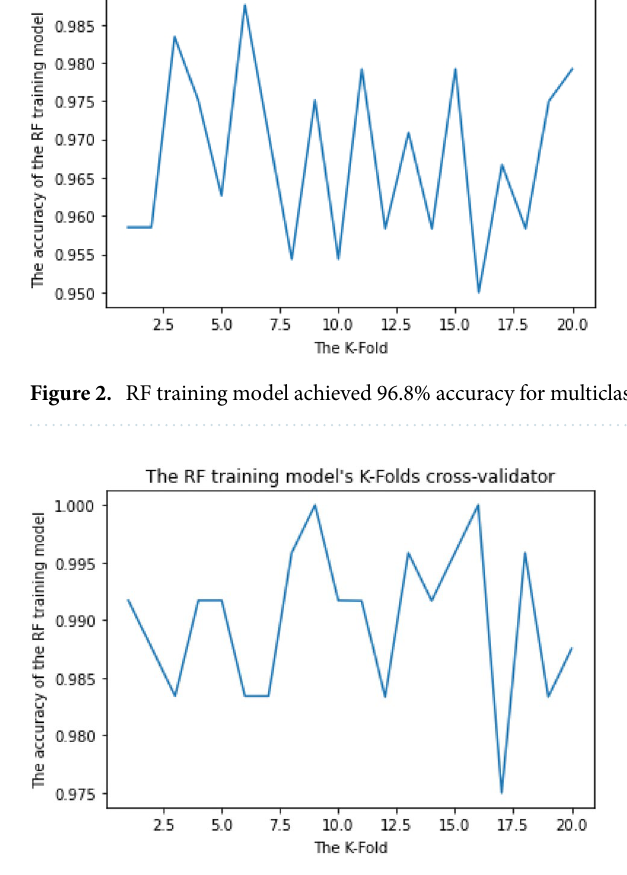
Figure 3. RF training model achieved 99% accuracy for binary-class